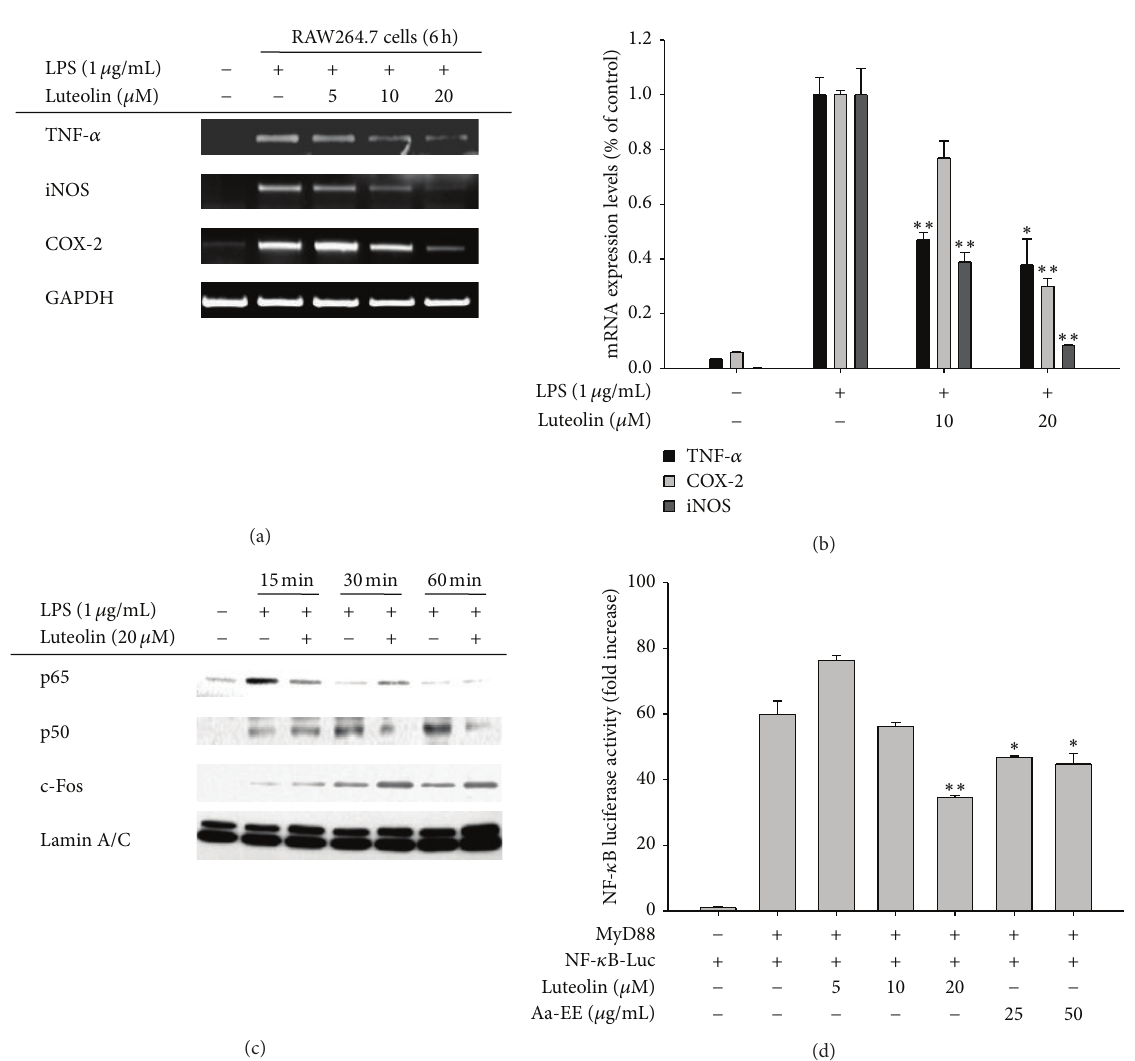
Figure 2: The effects of luteolin on iNOS, COX-2, and TNF- 𝛼 gene expression and transcriptional regulation in LPS-treated RAW264.7 cells. ((a)and(b))RAW264.7cells(5 × 10 6 cells/mL)wereincubatedwithLPS(1 𝜇 g/mL)inthepresenceorabsenceofluteolinfor6 h.iNOS,COX-2, andTNF- 𝛼 mRNAlevelsweredeterminedusingRT-PCR(a)andreal-timePCR(b).(c)RAW264.7cells(5 × 10 6 cells/mL)wereincubatedwith LPS (1 𝜇 g/mL) in the presence or absence of luteolin for the indicated times. After preparing nuclear fractions, the levels of total translocated transcription factors (p65, p50, c-Fos, and c-Jun) were determined by immunoblotting analysis. (d) HEK293 cells cotransfected with NF- 𝜅 B-Luc (1 𝜇 g/mL) and 𝛽 -gal (as a transfection control) plasmid constructs were treated with luteolin in the presence or absence of adaptor molecule (MyD88) for 12h. Luciferase activity was determined via luminometry. All data are expressed as the mean ± SD of experiments. ∗ 𝑝 < 0.05 and ∗∗ 𝑝 < 0.01 compared to the control